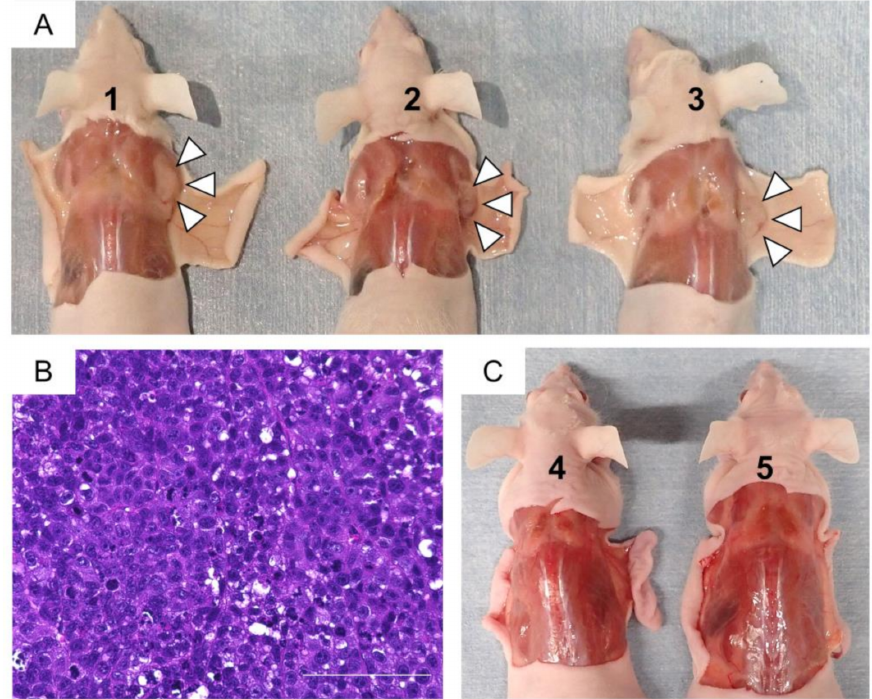
Figure 9. Tumorigenicity of the ADSC-K4DT and ADSC-K4D cells. ( A ) Inoculated Hela cells developed masses at injection sites (right side of the nude mice indicated by arrowheads), but no masses were generated by the ADSCs (No. 1), ADSC-K4DT cells (No. 2), or ADSC-K4D cells (No. 3) at the injected sites (left side of the nude mice) after 30 days. ( B ) Hematoxylin–eosin staining of tumor nodules derived from Hela cell-injected sites (scale bar = 100 µ m). ( C ) After 16 weeks, there were no generated masses in group 4 (left; primary ADSCs, right; ADSC-K4D cells, No. 4) or group 5 (left; ADSC-K4DT cells, right; PBS, No.